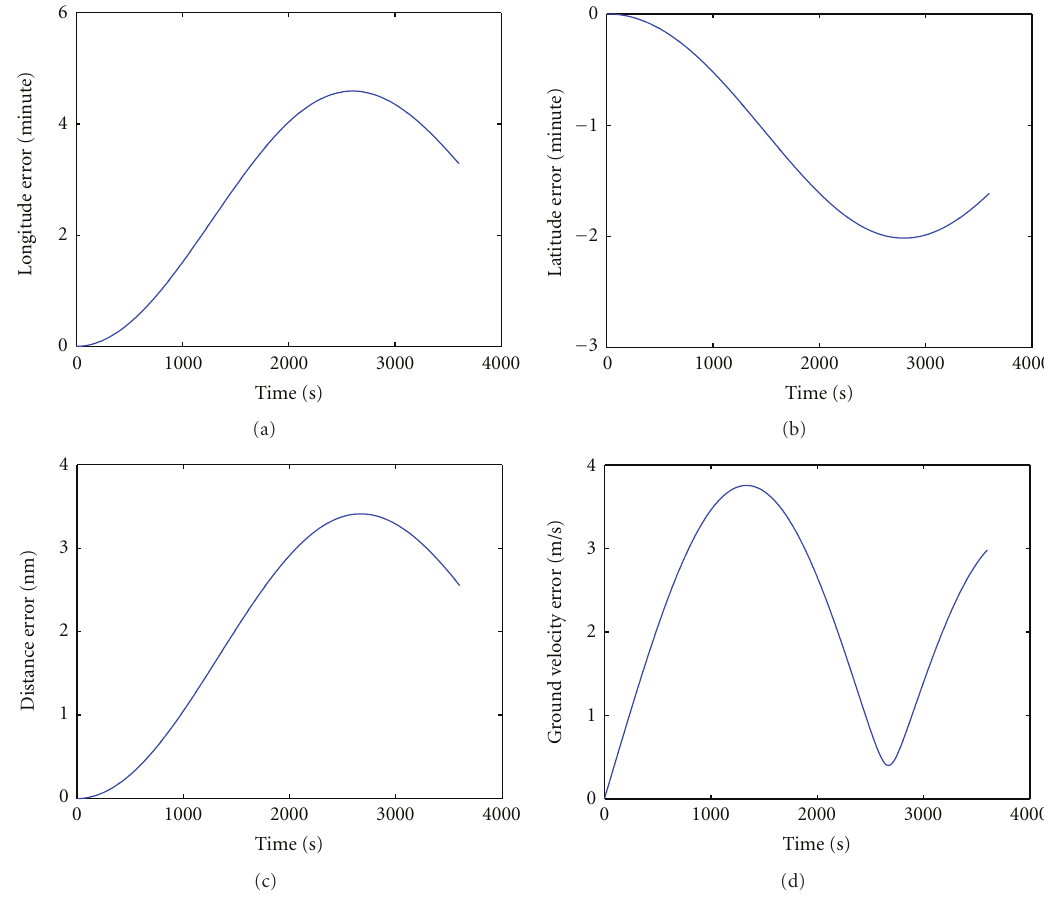
Figure 11: Position and velocity error of static